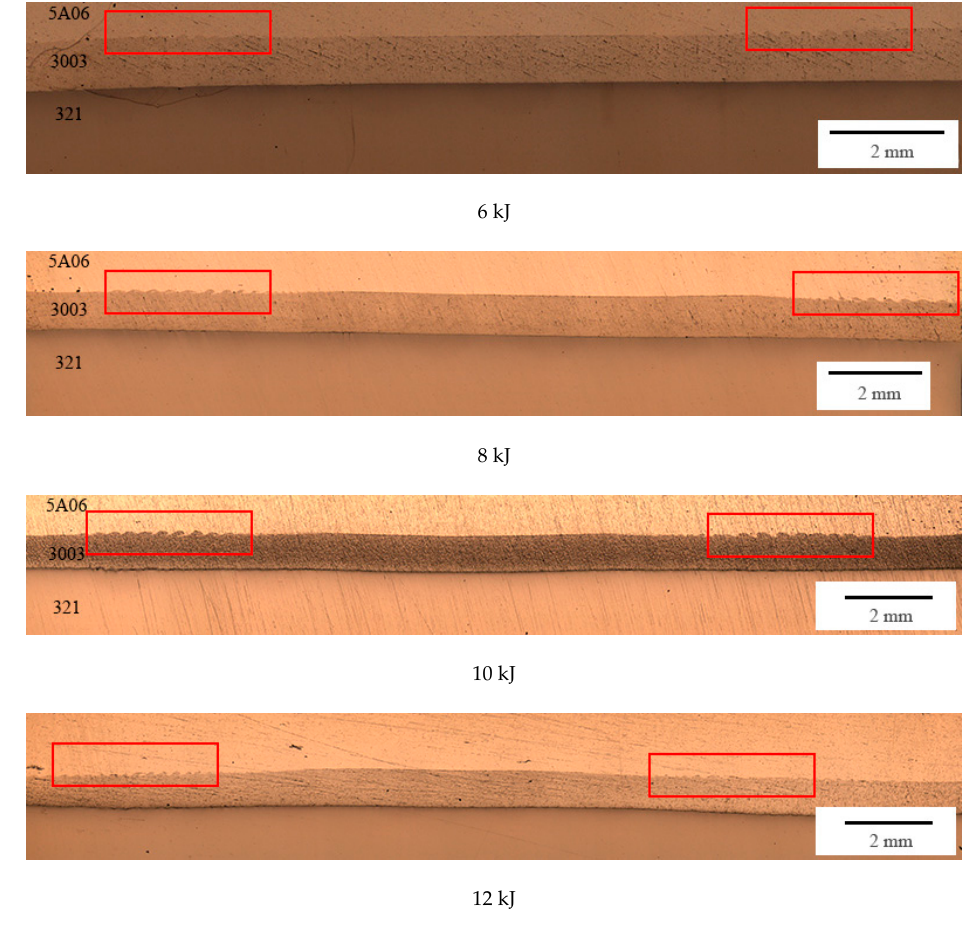
Figure 7. Interface morphologies of flyer and interlayer at 6 kJ, 8 kJ, 10 kJ, and 12 kJ input energies.